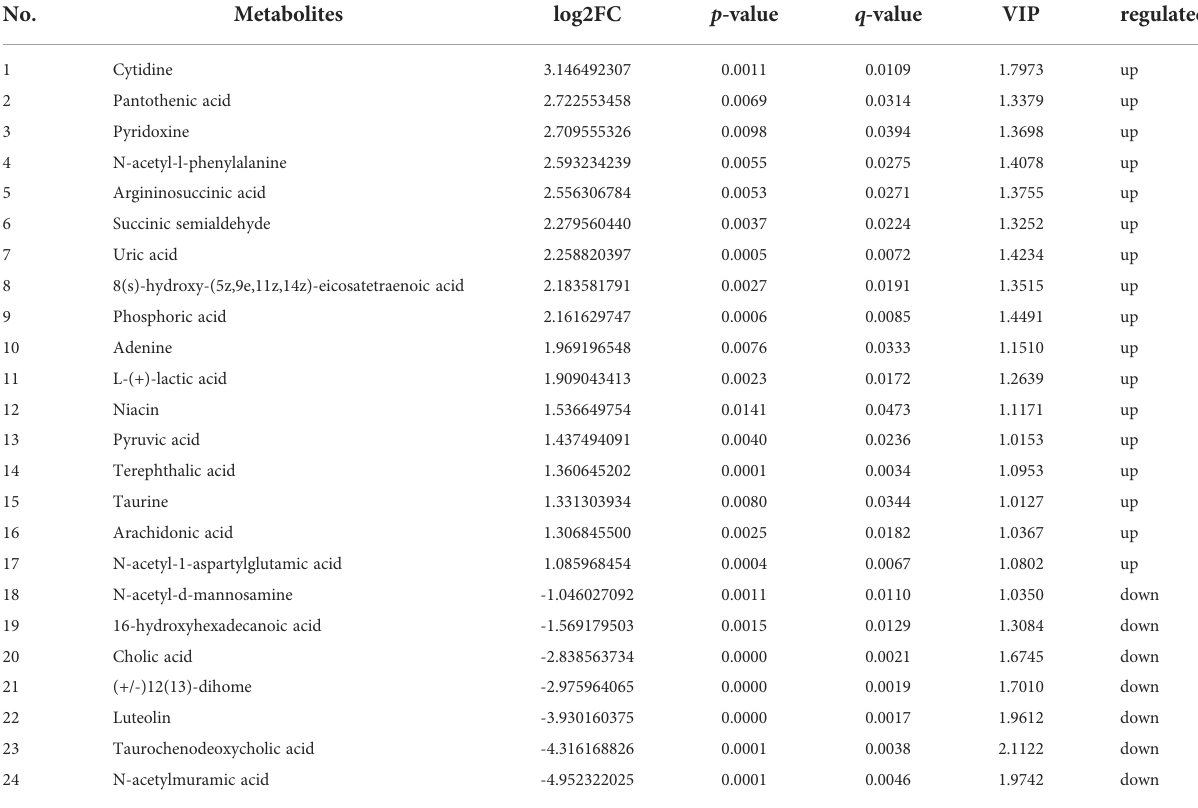
TABLE 3 24 known differential metabolites were signi fi cantly enriched in KEGG pathway enrichment analysis in negative ion mode. No.